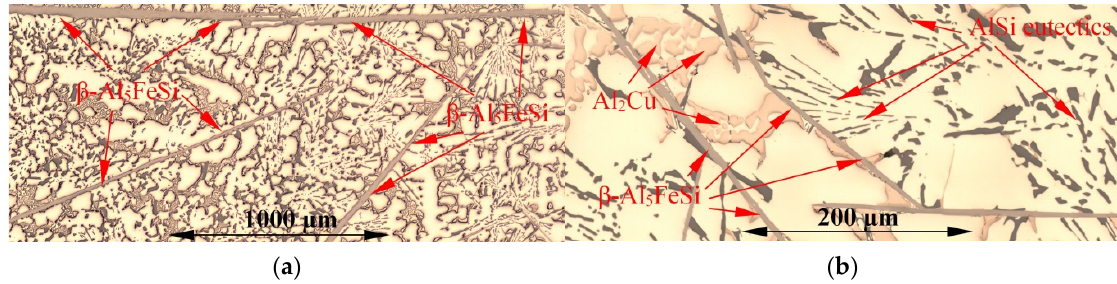
Figure 8. Mmicrostructures of the AlCu10Si10Fe1.0 specimen solidified with electromagnetic stirring. LOM: ( a ) magnifi- cation 100 and ( b ) magnification 500×.